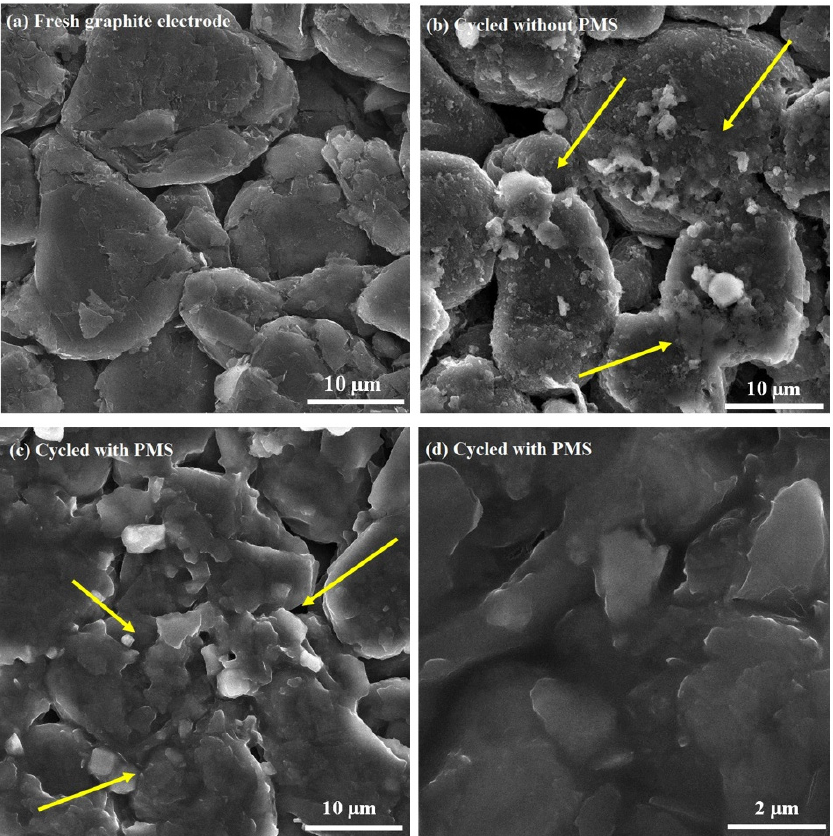
Figure 4. The SEM images of the graphite electrode: ( a ) before cycling, ( b ) after cycling in the electrolyte without PMS, ( c , d ) and after cycling in the electrolyte with PMS in two different magnifications. The arrows in ( b , c ), respectively, point out the reductive decomposition products of electrolytes without and with additive.